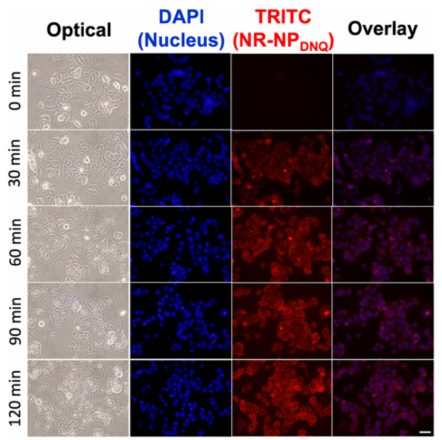
Figure 4. Fluorescence images of the internalization of NR-NP DNQ by MCF-7 cells for different time intervals: Nuclear staining with DAPI (blue color) and NR-NP DNQ (red color). (Scale bar: 20 µ m). Human umbilical vein endothelial cells (HUVECs) were used to evaluate the